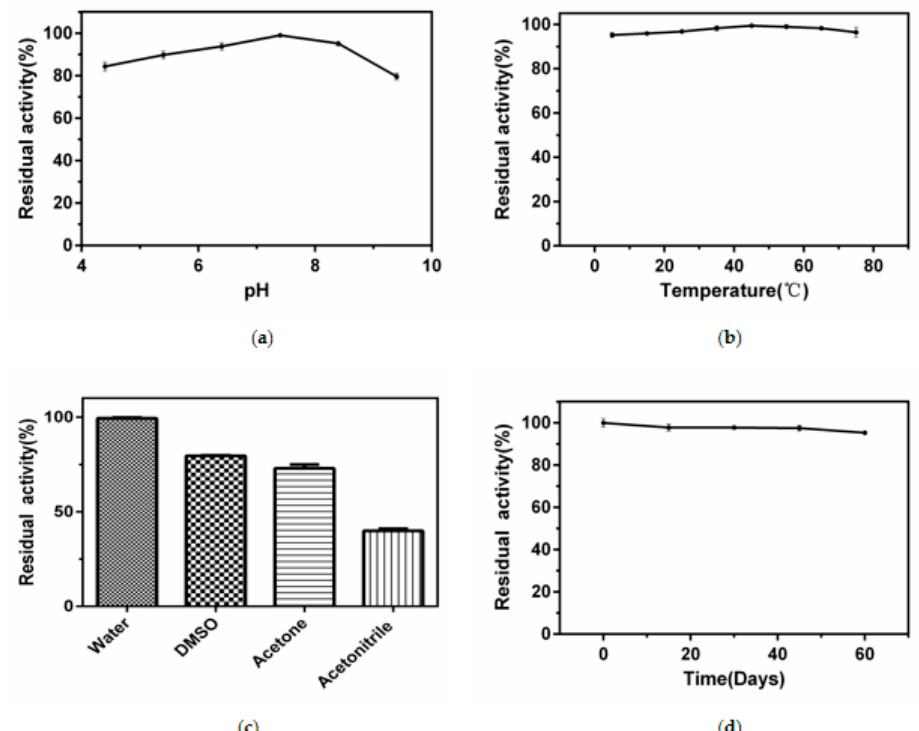
Figure 5. Stability of Dh–A–H–E. ( a ) Dh–A–H–E was incubated at a range of pH values from 4.4